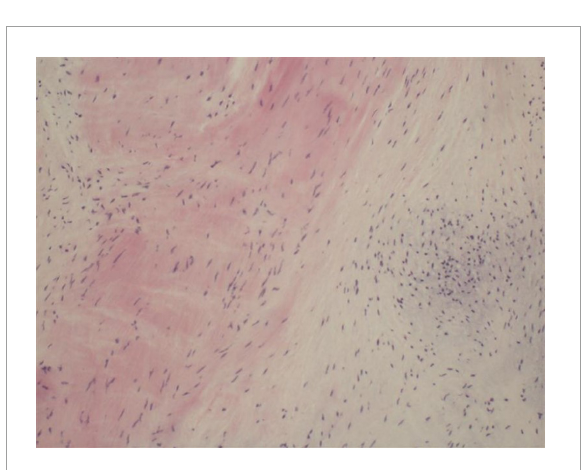
FIGURE4 Histopathology of excised valve demonstrating fibrous tissue hyperplasia with hyaline degeneration and no inflammatory cell